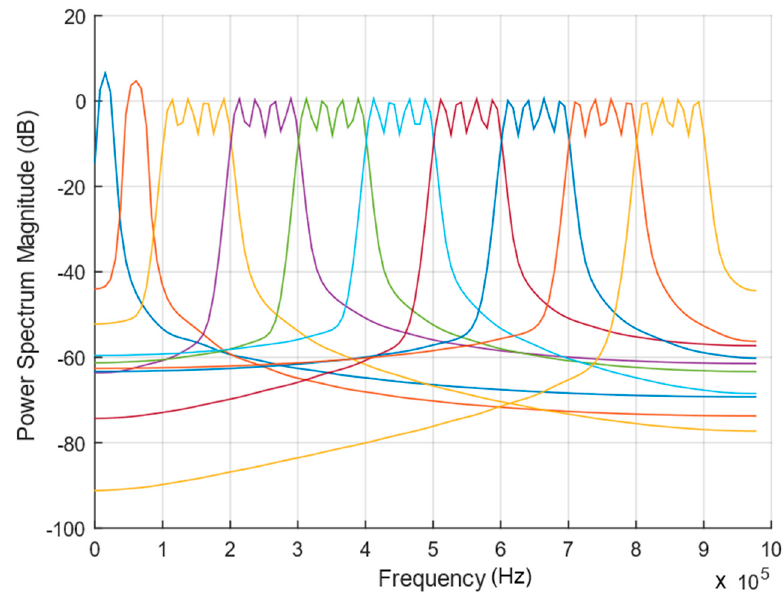
Figure 10. Power spectrum of the 10 chirp signals selected for the field tests.